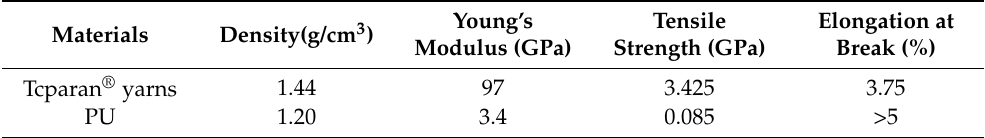
Table 2. Mechanical properties of Tcparan ® yarns and PU